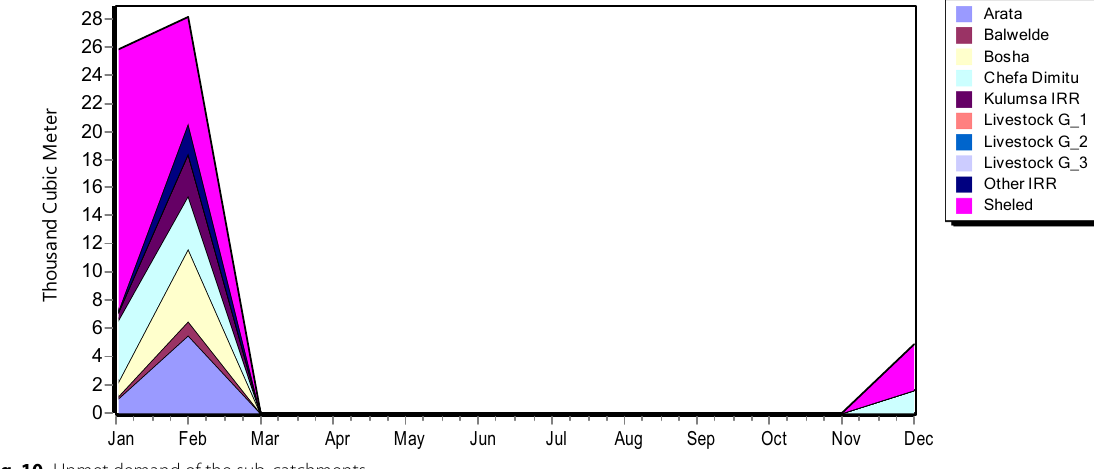
Fig. 10 Unmet demand of the sub-catchments